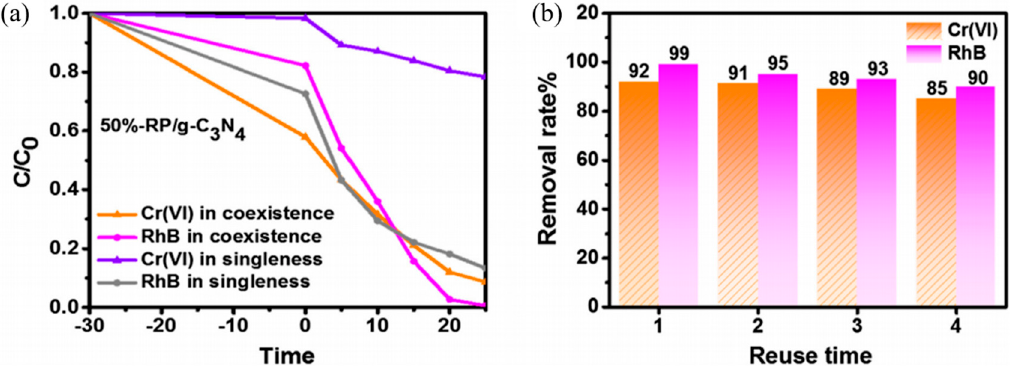
Figure 7. ( a) Photoreduction of Cr (VI) in the presence and absence of Rhodamine B (RhB) and ( b ) removal rate of both Cr (VI) and RhB at di ff erent individual cycles. Adapted from [155], with permission removal rate of both Cr (VI) and RhB at different individual cycles. Adapted from [155], with from Elsevier, permission from Elsevier, 2019.